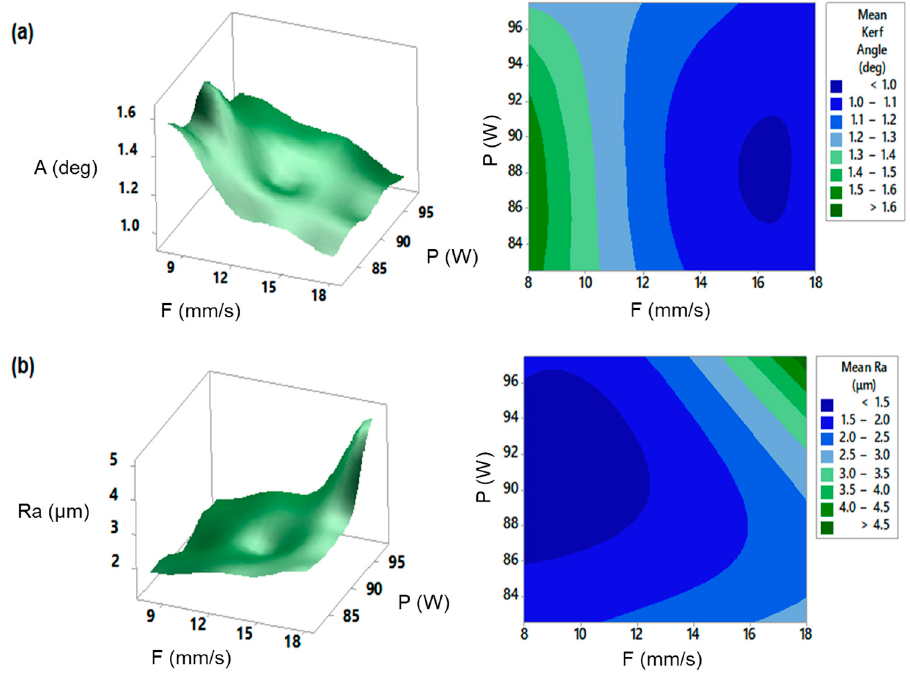
Figure 4. Surface and contour plots for the objectives of: ( a ) mean kerf angle, ( b ) mean surface rough-